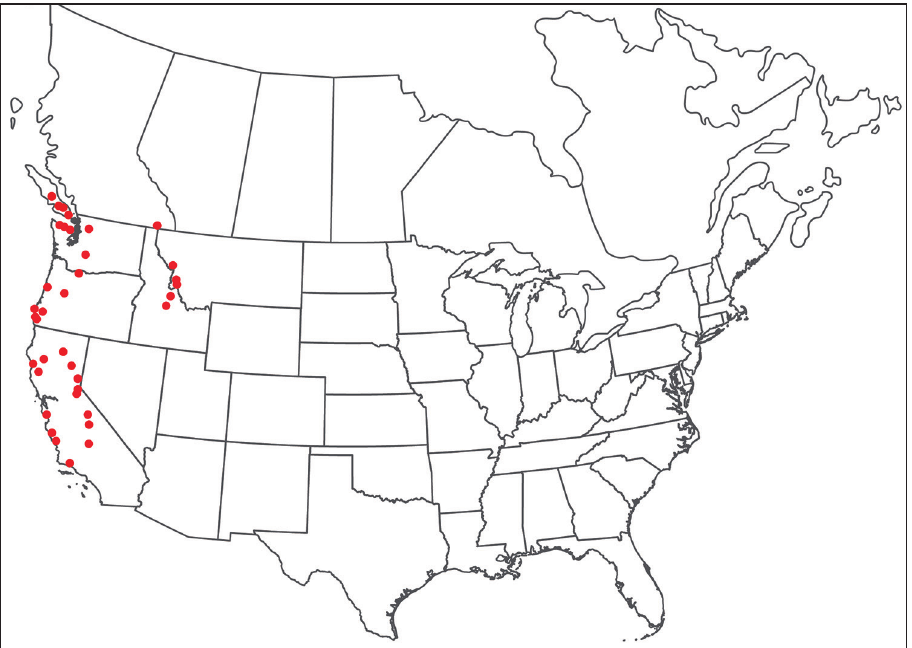
Figure 249. Torrenticola tahoei